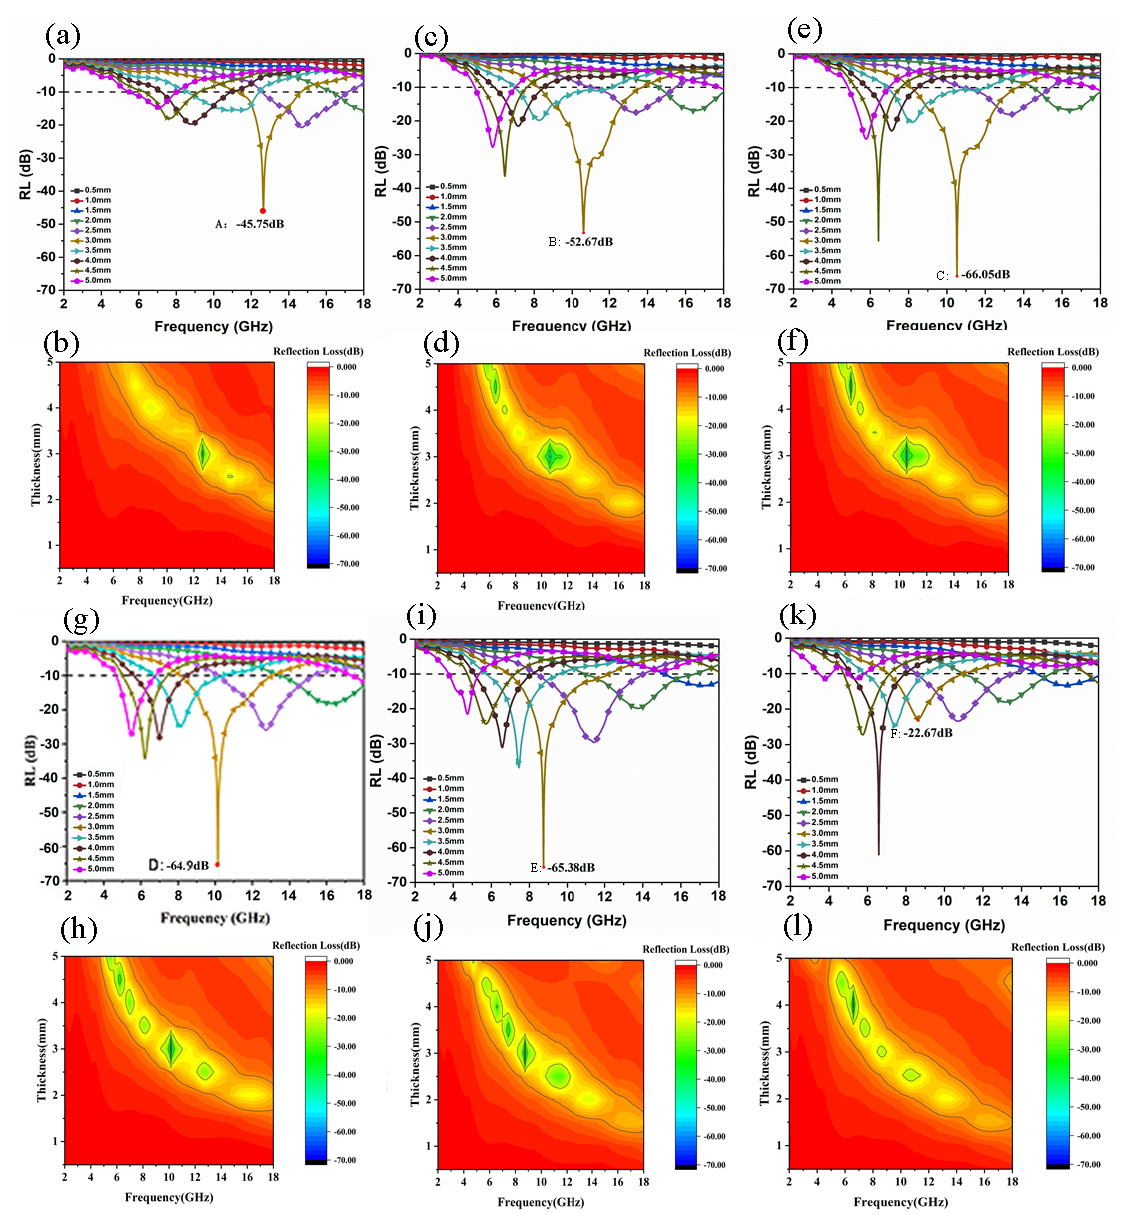
Figure 6. The simulated RL curves of three-layer magnetic foams ( a , b ) S1, ( c , d ) S2, ( e , f ) S3, ( g , h ) S4, ( i , j ) S5, and ( k , l ) S6 electromagnetic absorption RL curve diagram and corresponding 2D simulation diagram.